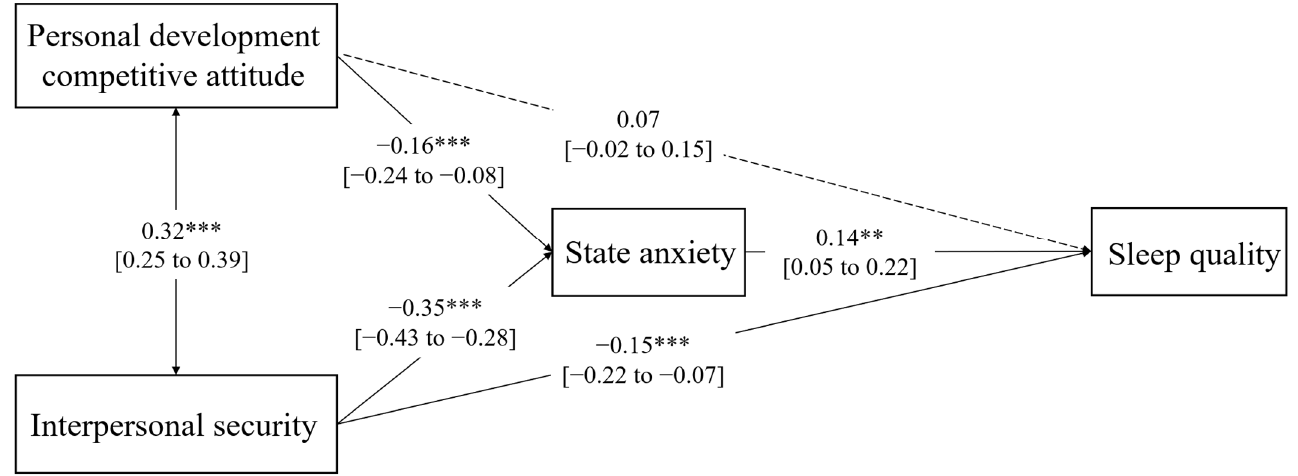
Figure 3. Path analysis model for personal development competitive attitude with standardized coefficients. Note: The solid line refers to the statistically significant path. The dashed line refers to the statistically insignificant path. ** p < 0.01, *** p < 0.001. 95% CI are detailed between brackets.